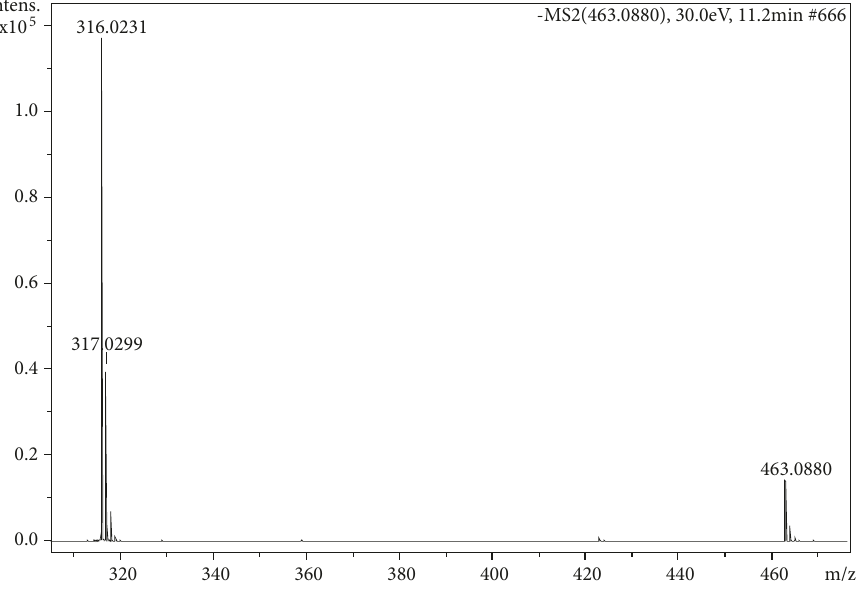
Figure 6: MS/MS spectrum of the ion m/z